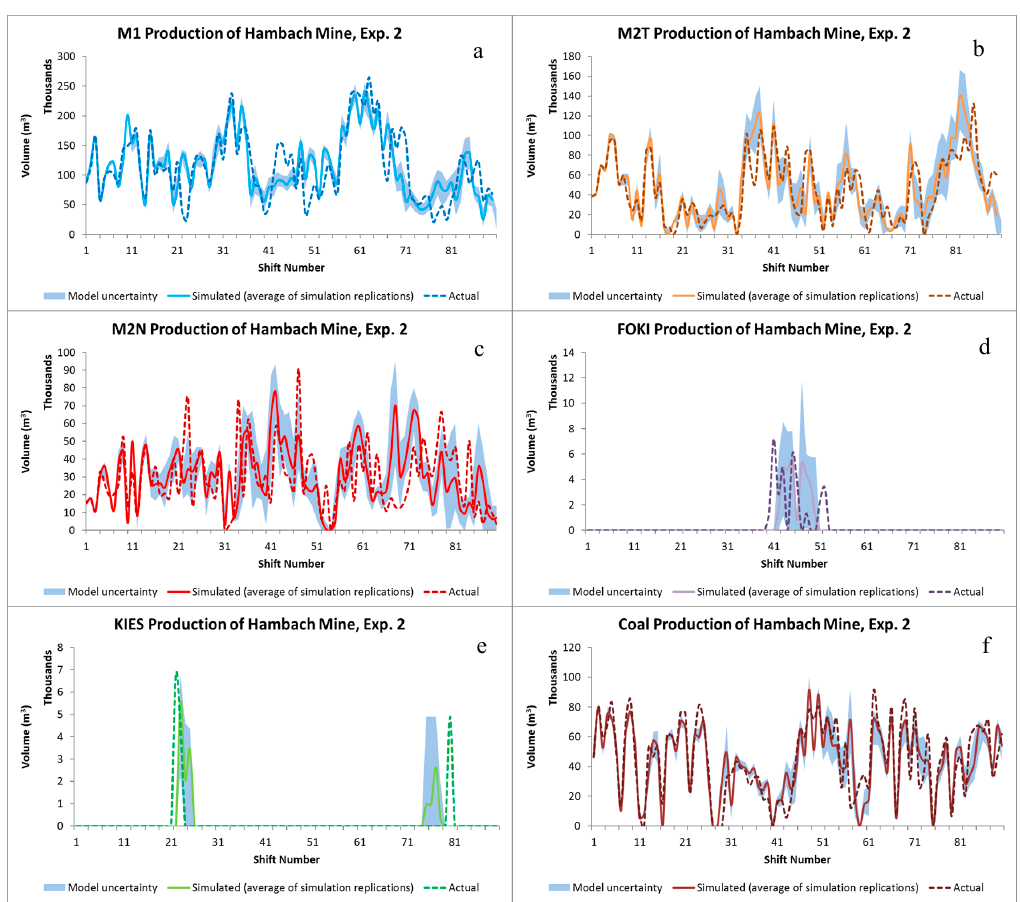
Figure 22. The shift-based production of different materials of the Hambach mine, Experiment